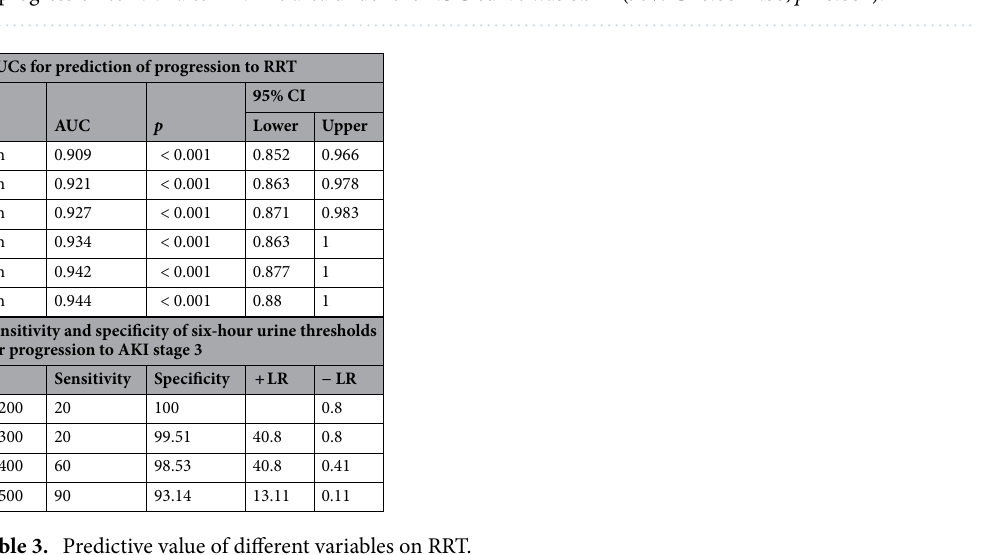
Figure 3. ( A ) Urine output in the first hour for prediction of progression to AKI stage 3 after LT. The area under the ROC curve was 0.940 (95% CI 0.905–0.976, p < 0.001); 3( B )Total six-hour urine output for prediction of progression to RRT after LT. The area under the ROC curve was 0.944 (95% CI 0.88–1.00, p < 0.001).